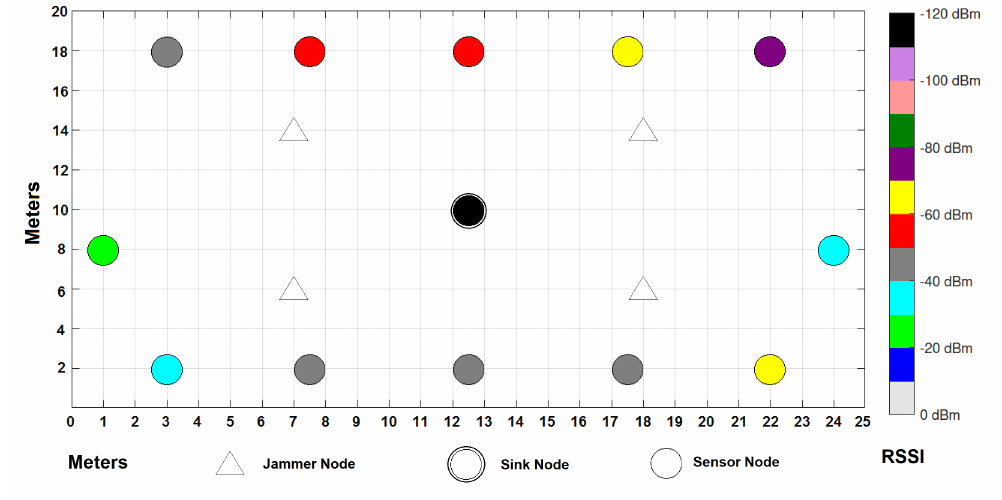
Figure 14. RSSI results per node under a cooperative scheme.